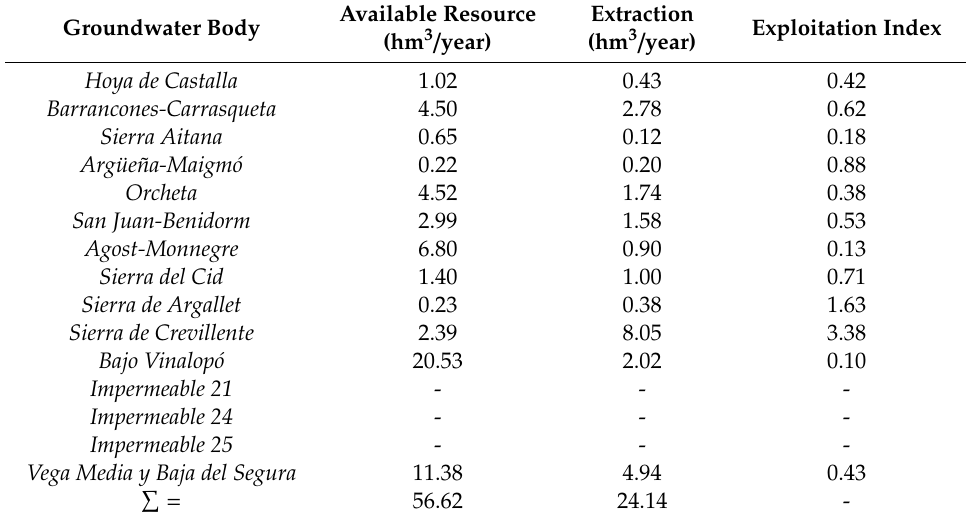
Table 1. Groundwater bodies and descriptive features (available resource, extraction, and exploitation index), weighted according to municipal areas. Source: elaborated with data from